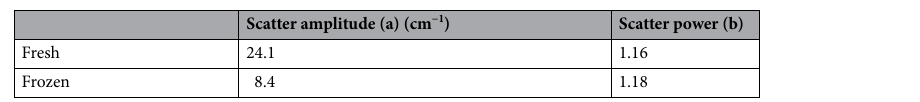
Table 1. Values of scatter amplitude and scatter power attained for fresh pancreas and pancreatic tissue undergoing the freezing